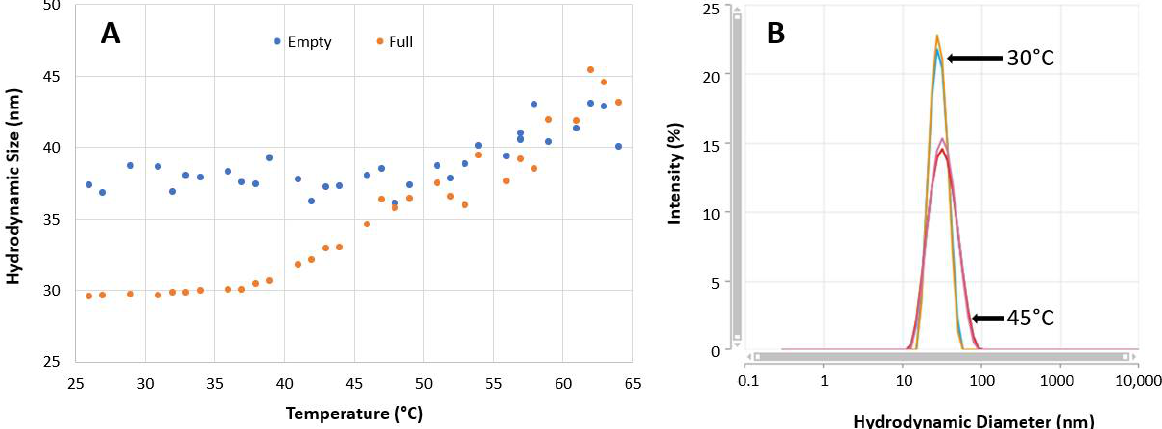
Figure 5. Thermal stress conditions for full and empty rAAV5 stability study with the Zetasizer Ultra. ( A ) Hydrodynamic diameter trend with temperature. ( B ) Overlay of intensity particle size distributions at 30 °C and 45 °C for full rAAV5 samples.